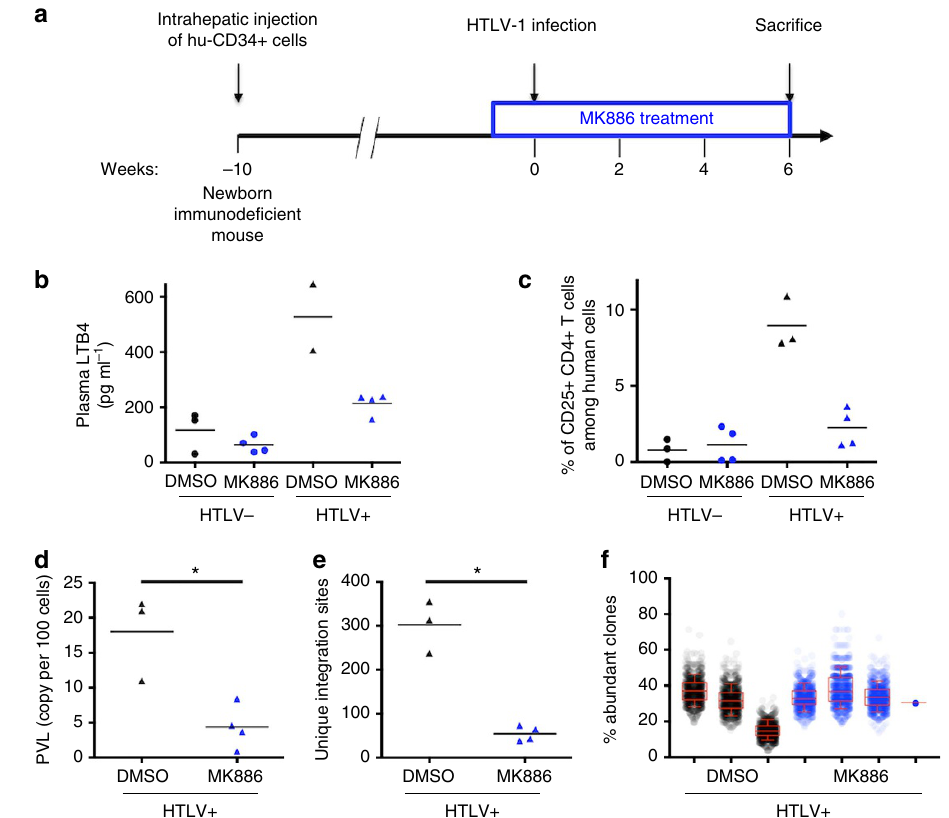
Figure 6 | Blocking LTB4 synthesis during neoinfection in vivo results in lower HTLV-1 PVLs and a decrease in the number of infected clones. ( a ) Experimental procedure. Mice were considered humanized 8–10 weeks after CD34 þ cell transplantation. Mice were then treated with IP injection of MK886 (5nmol per mouse) three times a week. Injection with DMSO was used as control. One week after the initial injection, lethally irradiated MT2 cells were injected intraperitoneally. Six weeks after infection, mice were killed. Together, 14 mice were used. ( b ) LTB4 is increased in the plasma of HTLV-1-infected humanized mice. Six weeks after infection, plasma was collected and LTB4 levels were determined by ELISA. P value ¼ 0.006; bar represents mean. Kruskal–Wallis test. ( c ) The frequency of human splenocytes expressing CD25 is lower in infected animals treated with MK886. Six weeks after infection, mice were killed and splenocytes were collected. The percentage of human CD4 Tcells (that is, hCD45 þ ) positive for CD25 was determined by flow cytometry. P value ¼ 0.018; bar represents mean. Kruskal–Wallis test. ( d ) The PVL is lower in HTLV-1-infected mice treated with 5nmol MK886. PVL is reported as the number of genomic tax copies per 100 human cells on splenocytes. P value ¼ 0.029; bar represents mean. Mann–Whitney U -test. ( e ) The number of UIS is lower in HTLV-1-infected mice treated with MK886. The number of independent HTLV-1-infected clones was determined by HTS clonality analysis (Supplementary Table 1). P value ¼ 0.028; bar represents mean. Mann–Whitney U -test. ( f ) The abundance of infected clones is not altered upon MK886 treatment. Abundant and non-abundant clones, defined by Z 2 or a single sequencing read, respectively, were determined for each animal by iterative subsampling ( N ¼ 1,000) of an equivalent number of reads ( n ¼ 59, Supplementary Table 1) within the total read number that supported LTR-host junctions. Dot plots represent the distribution of the percentage of abundant clones (number of abundant clones/total number of UIS) over 1,000 subsampling iterations for each animal. P value ¼ 0.48; Median, quartile and 10–90th percentile are presented in the Box-and-Whisker plot. Mann–Whitney U